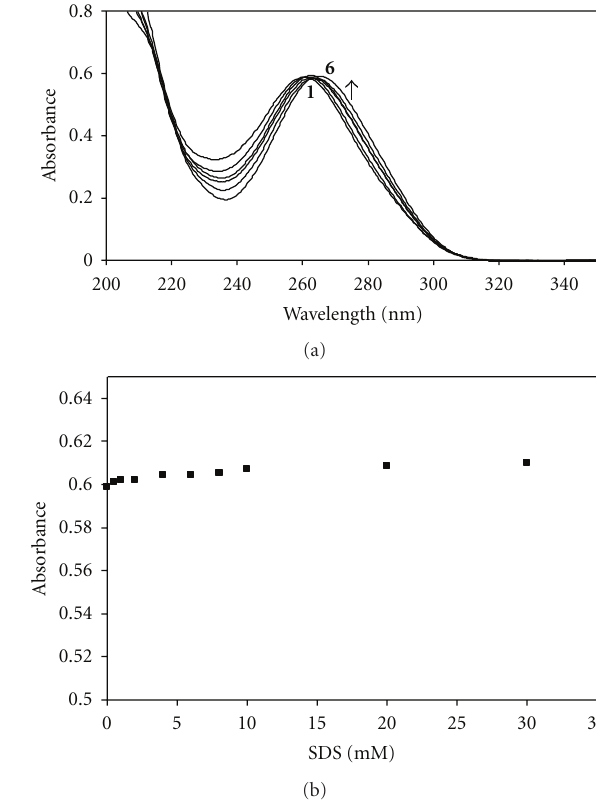
Figure 2: (a) Visible absorption spectra of TMP (4 . 0 × 10 − 5 M) at various concentrations of SDS at 298K: (1) no SDS, (2) 2 mM, (3) 4mM, (4) 8mM, (5) 10 mM, (6) 20 mM SDS. (b) The absorbance change of 4 . 0 × 10 − 5 M TMP (below and above the CMC) with the concentration of SDS.